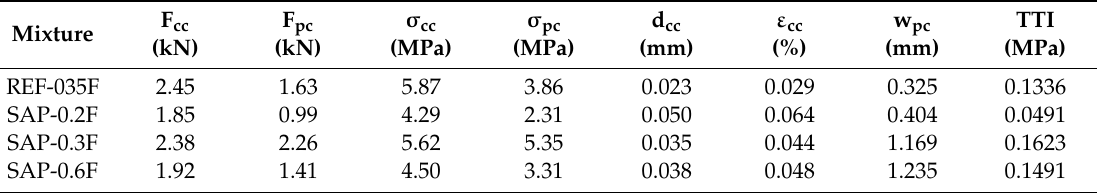
Figure 7. Stress x strain curve of: ( a ) SFRC with varying SAP content; ( b ) typical curves of strain 327 softening behavior. 328 Table 4. Tensile properties of SFRC specimens at 28 days. 329